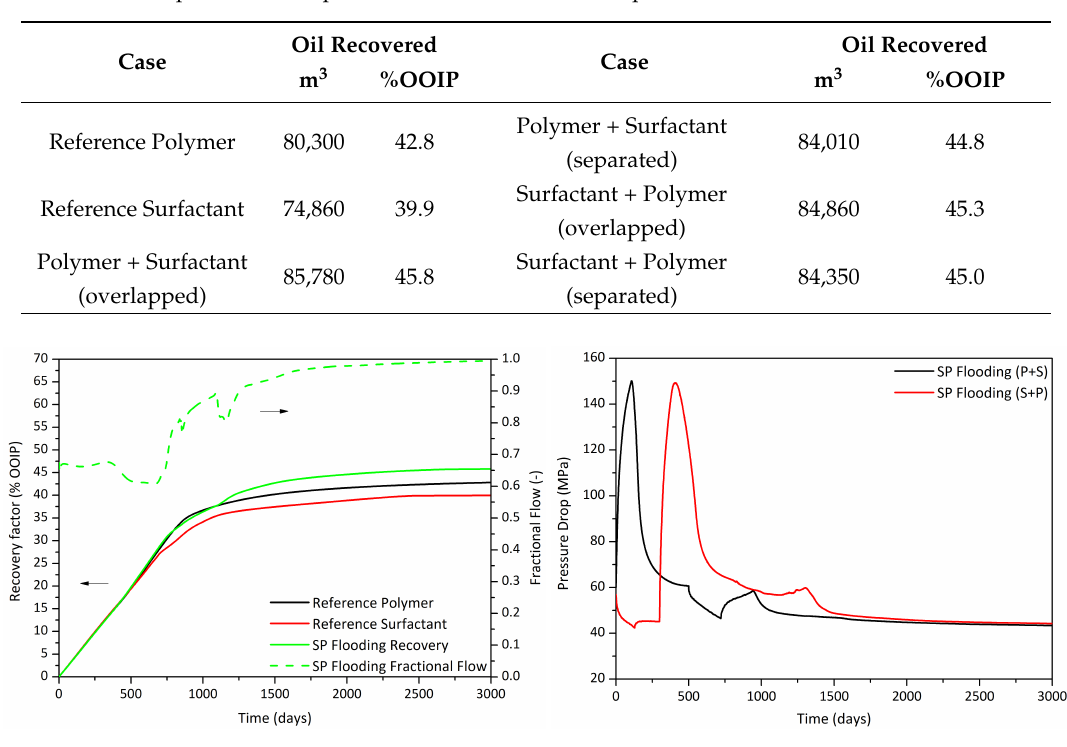
Table 5. Results of the recovery process for different SP flooding schemes considering adsorption of the chemical species and the presence of the salt as fifth component.